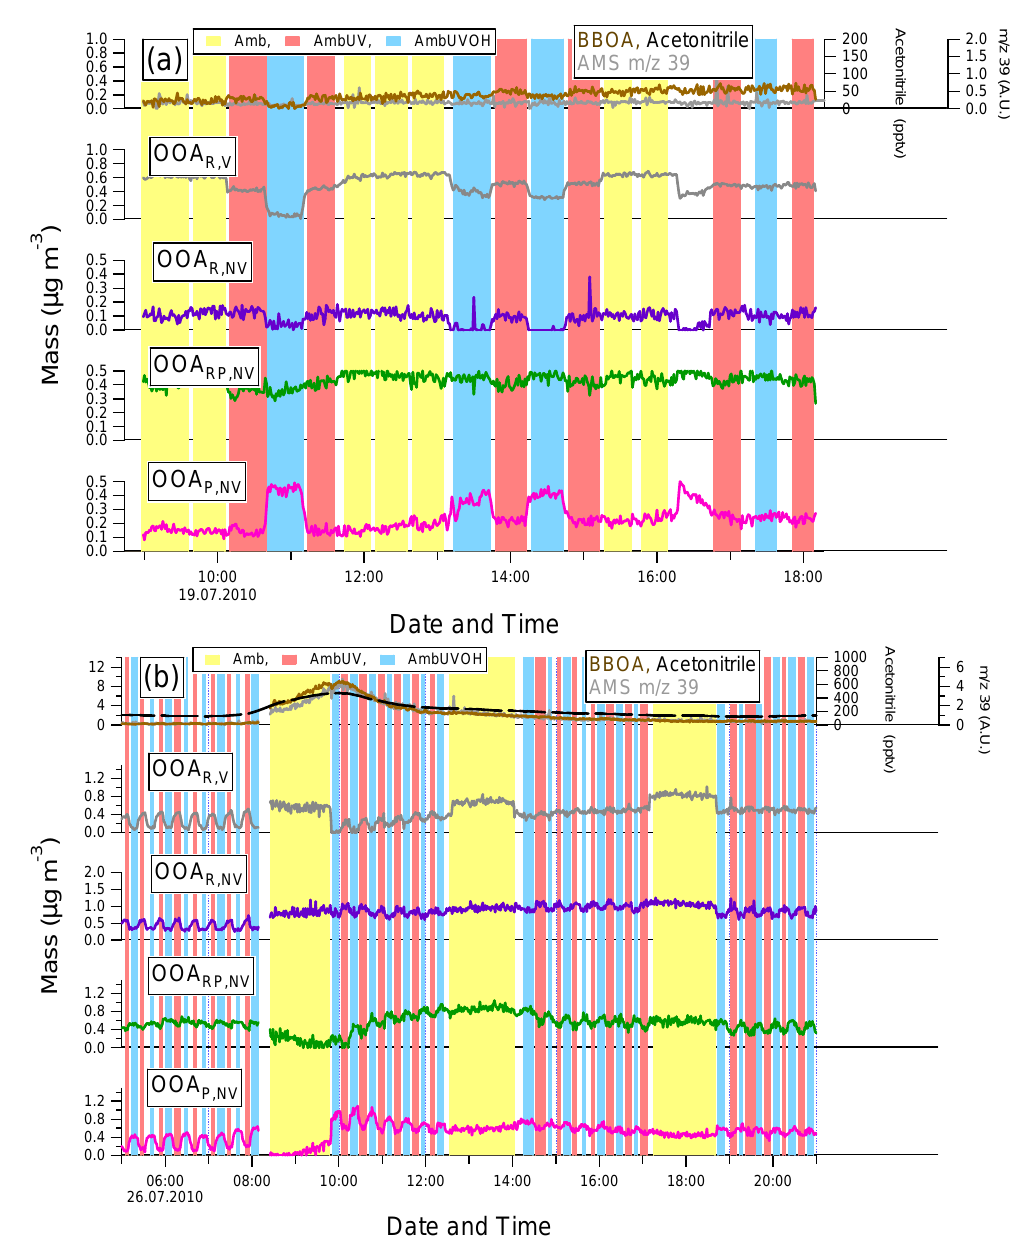
Fig. 8. Excerpted periods from the factor time series from the 5-factor solution to the TPOT PMF dataset, showing a typical day (a) and a biomass burning plume (b) . Amb, AmbUV, and AmbUVOH periods are indicated by colored shading. PMF factors are shown as colored traces. PTR-MS measurement of acetonitrile (black) and AMS estimate of potassium (gray) are also